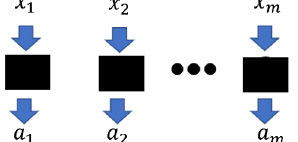
FIG. 3. Bell test. A Bell test consists of m -distant parties performing different measurements on their systems. The choice of measurements by party i is labeled by x and the corresponding i output by a . The different systems are seen as back boxes, each i producing the classical output a after receiving the classical i input x . The whole scenario is described by the conditional i